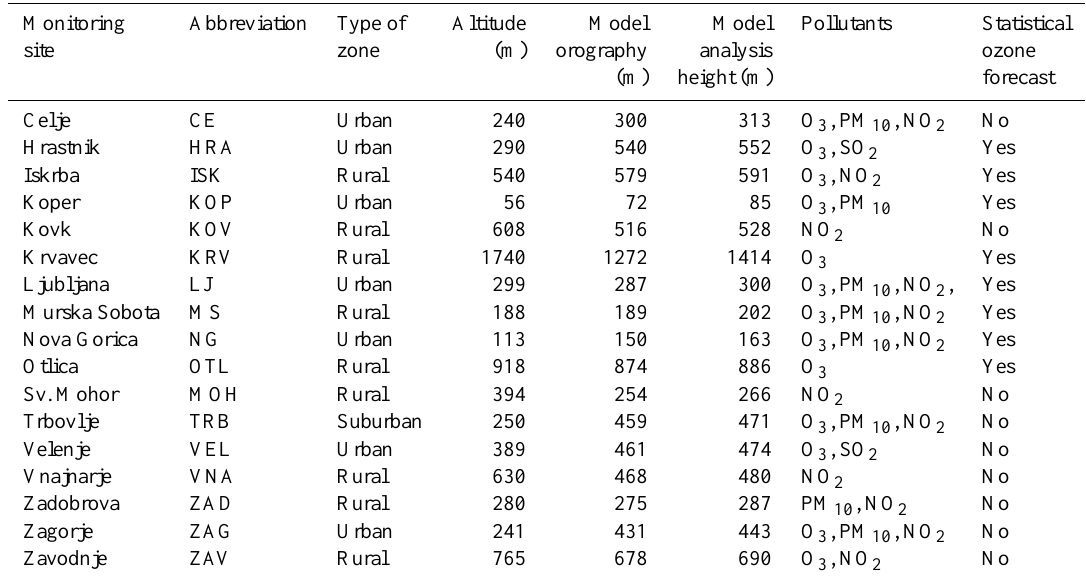
Table 1. AQ monitoring sites.